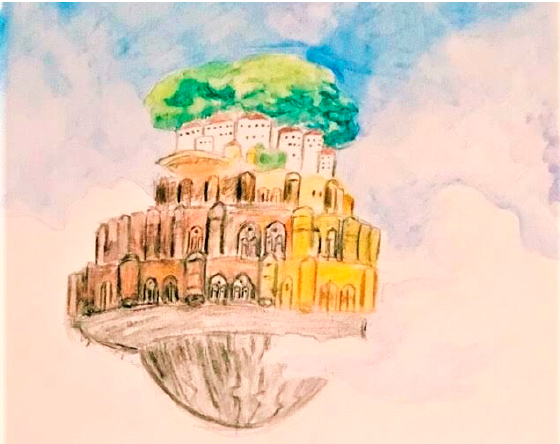
Figure 3. Laputa the floating city shrouded by clouds in the sky, as depicted in Laputa: Castle in the Sky (1986).